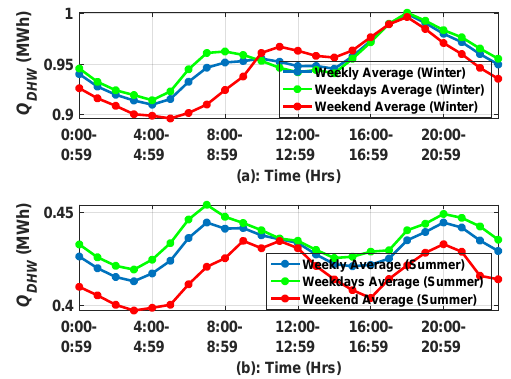
Figure 5. Average hourly thermal consumption of week, weekdays and weekends from period (December 2016–August 2017) ( a ) Winter ( b )